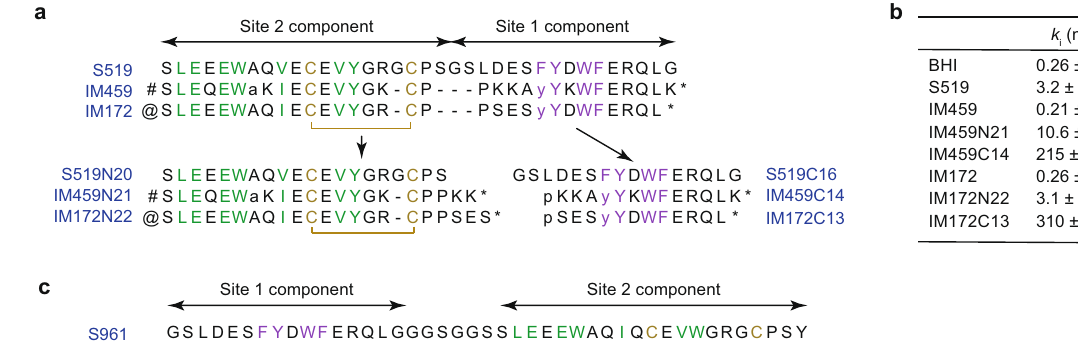
Fig. 1 | IR-binding peptides and their biochemical properties. a [Site-2]-[Site-1] fusion peptides S519 6 , IM459 and IM172 7 and their isolated [Site 2]- and [Site 1] components. Non-native amino acids and modi fi cations are as follows:- a: 2-aminoisobutyric acid; p: N-acetylproline; y: O-methyltyrosine; #: N-terminal (4- aminomethyl)phenylacetylation; @: N-terminal phenylacetylation; *: C-terminal amidation. b Receptor inhibition ( k i ) and auto-phosphorylation (EC 50 ) constants (see Supplementary Fig. 2b – f). BHI=biosynthetic human insulin (control). Errors